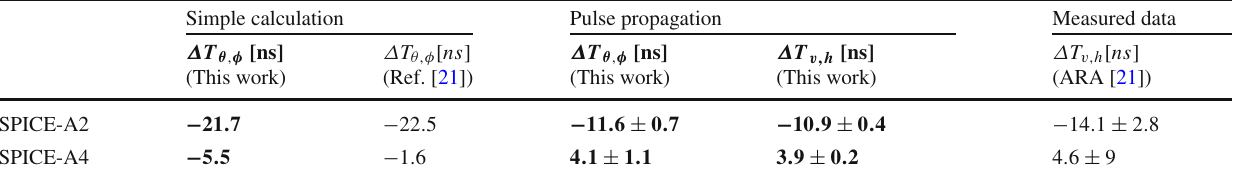
Table 1 Summary of time delay measurements and predictions for the pulse propagation from 1000m depth to the ARA A2 and A4 stations. The first two columns show the accumulated time delay in the θ and φ polarization component using Eq. (9) from our model and the sim- plified calculation from [21]. The third/fourth columns show the time delay extracted from the propagated waveforms of the electric field